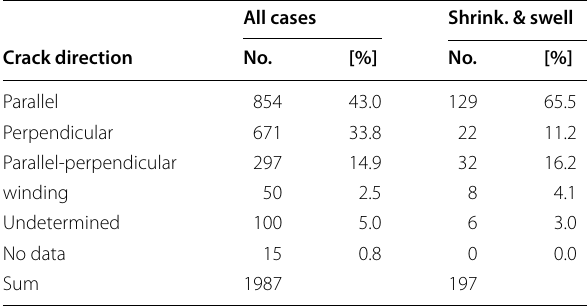
Table 4 Percentage of crack patterns, all cases and cases of shrinkage and